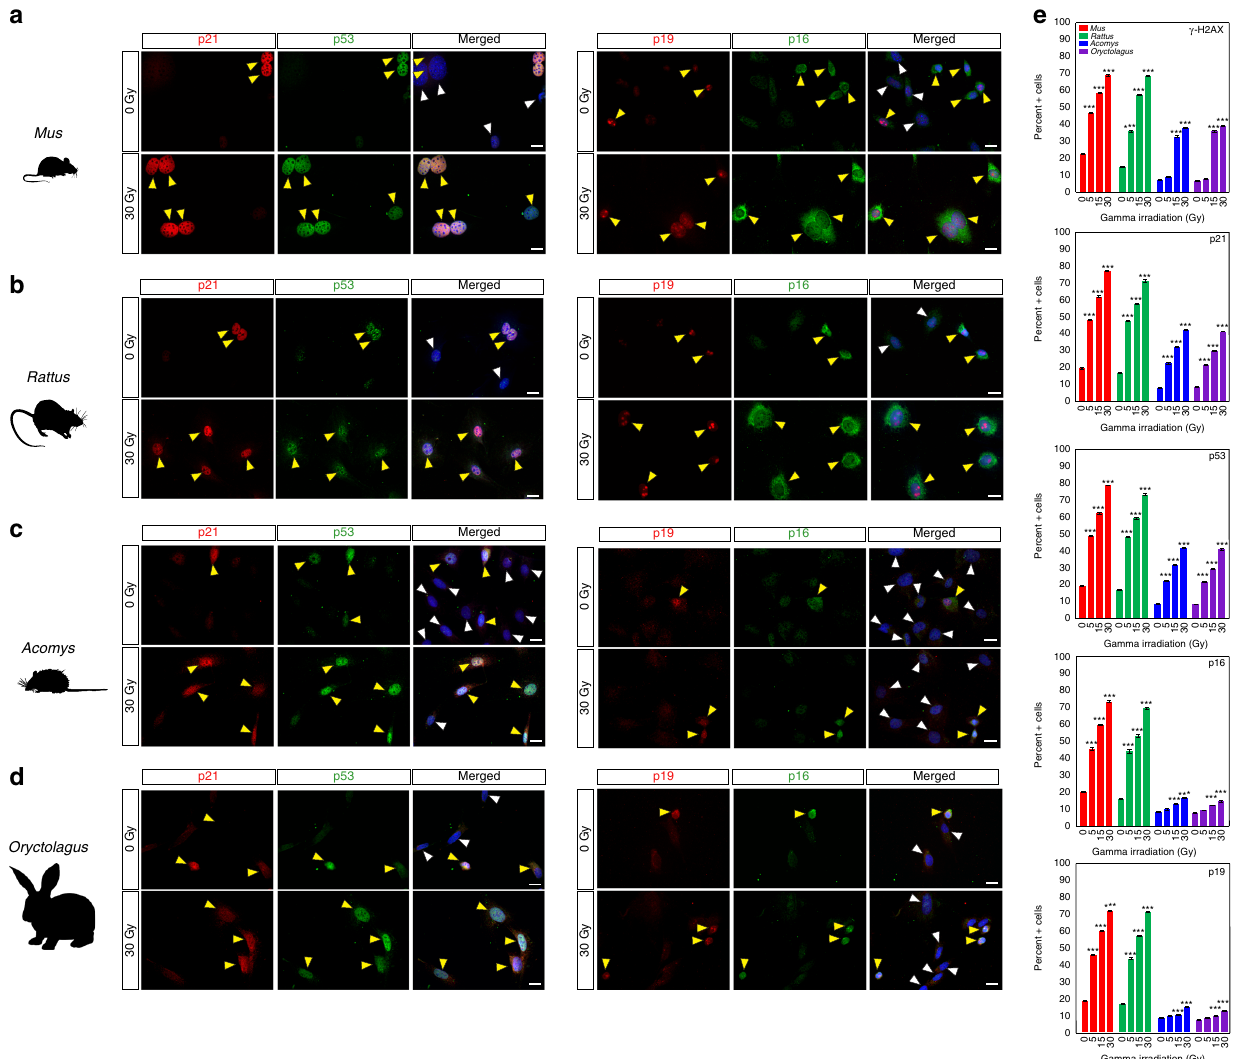
Fig. 5 Gamma irradiation induces DDR and cellular senescence in all species. a – d Cells from all four species were exposed to gamma radiation at 0 (control), 5, 15, and 30 Gy and fi xed 6 h later ( n = 4/species). The representative images show p21, p53, p16, and p19 positive cells in control (0 Gy) and after 30 Gy in Mus ( a ), Rattus ( b ), Acomys ( c ), and Oryctolagus ( d ). e Fibroblasts from regenerating species showed no signi fi cant increase in γ -H2AX + cells at 5 Gy, whereas all species demonstrated a signi fi cant increase in DNA damage at 15 and 30 Gy (Supplementary Table 22). Fibroblasts from all four species demonstrated a signi fi cant increase in p21 + and p53 + cells at all three radiation doses (Supplementary Tables 23 – 24). In contrast, fi broblasts from regenerating species showed minimal activation of p16 and p19 in response to gamma radiation, where fi broblasts from Mus and Rattus strongly activated p16 and p19 (Supplementary Tables 25 – 26). Scale bars in panels a – d = 20 µ m. *** P < 0.0001, ** P < 0.001, * P < 0.05. Error bars = S.E.M. Source data